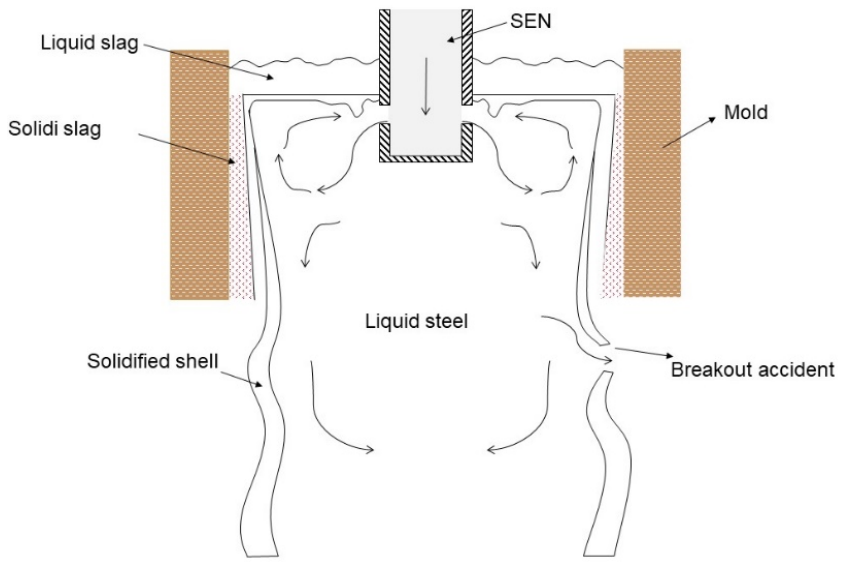
Figure 1. Schematic diagram of fluid field in mold. Although some studies have been performed on the flow field in the mold, there are still few reports on the influence of the structural details of the nozzle on the flow field distribution. The influences of nozzle inclination, nozzle area ratio, and side-hole aspect ratio on the distribution of liquid steel flow field is still unclear. The molten steel flows into the mold through the nozzle and then changes the flow field of molten steel. The flow field affects the solidification of slab, the melting of mold flux, and the thickness of slab shell. Therefore, the nozzle structure has an important impact on the quality of slab. Thus, this paper develops a three-dimensional nozzle model in which the nozzle inclination, nozzle area ratio, and side-hole aspect ratio can be changed. The proposed model can provide theoretical basis and guidance for nozzle